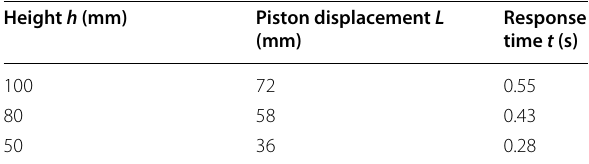
Table 4 Response time of the height control system Height h (mm) Piston displacement L